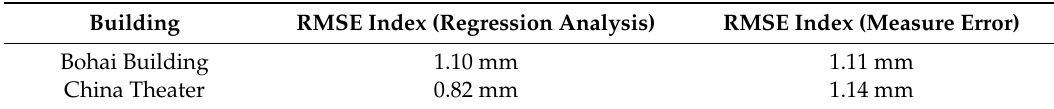
Table 6. Different Root Mean Square Error (RMSE) analysis results.